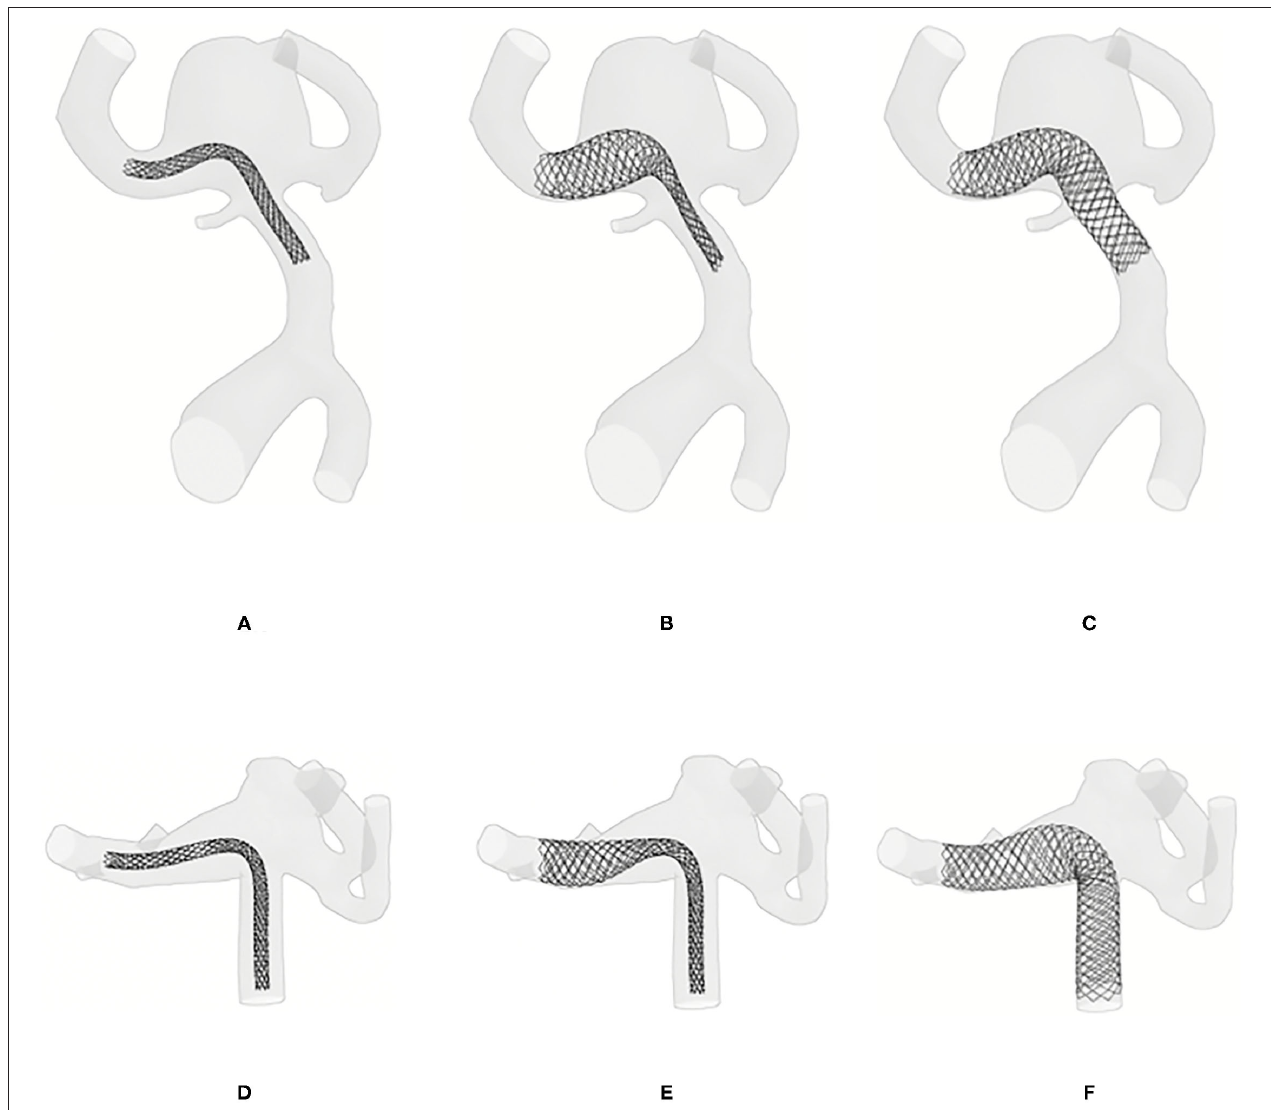
FIGURE 3 | Virtual deployment process. (A) Crimped LVIS EVO flow-diverter placed on the centerline of the target vessel. (B) Half way through the LVIS EVO expansion process, starting from the distal to proximal side of the device with respect to aneurysm sac. (C) Configuration of full expanded LVIS EVO. (D–F) The deployment of BABY LEO in WNBA